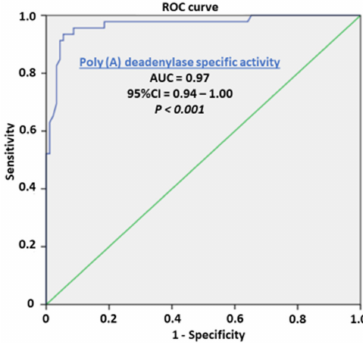
Figure 2. Receiver operating characteristic curve showing the performance of Poly(A) deadenylase specific activity in predicting prostate